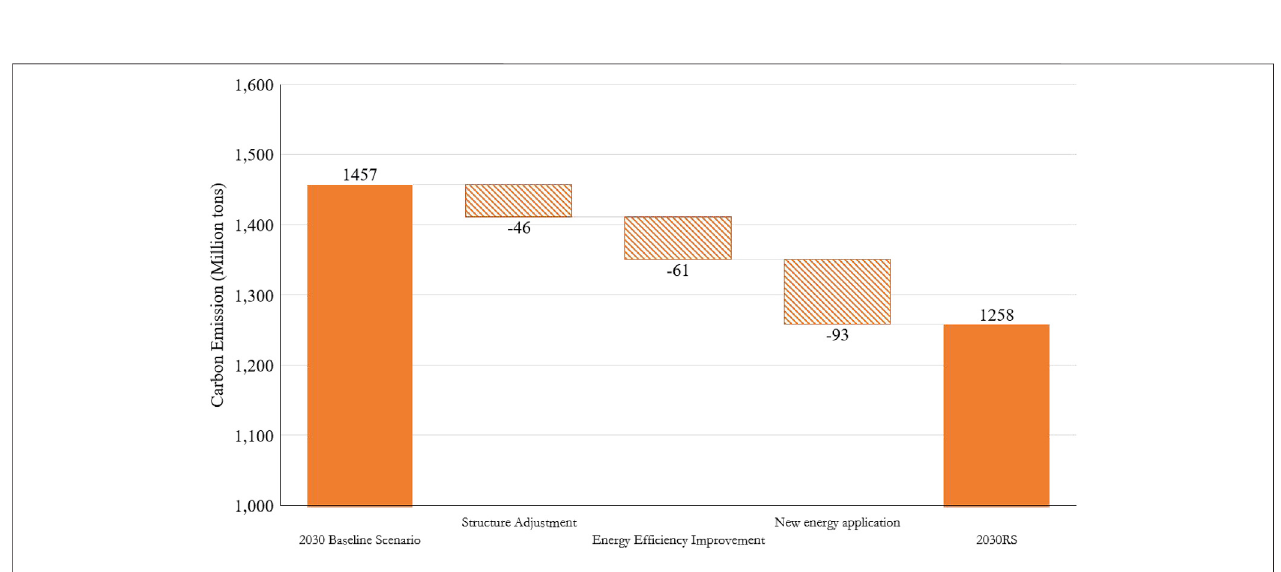
FIGURE 13 | Deconstruction of carbon emissions under the Radical scenario in 2030.